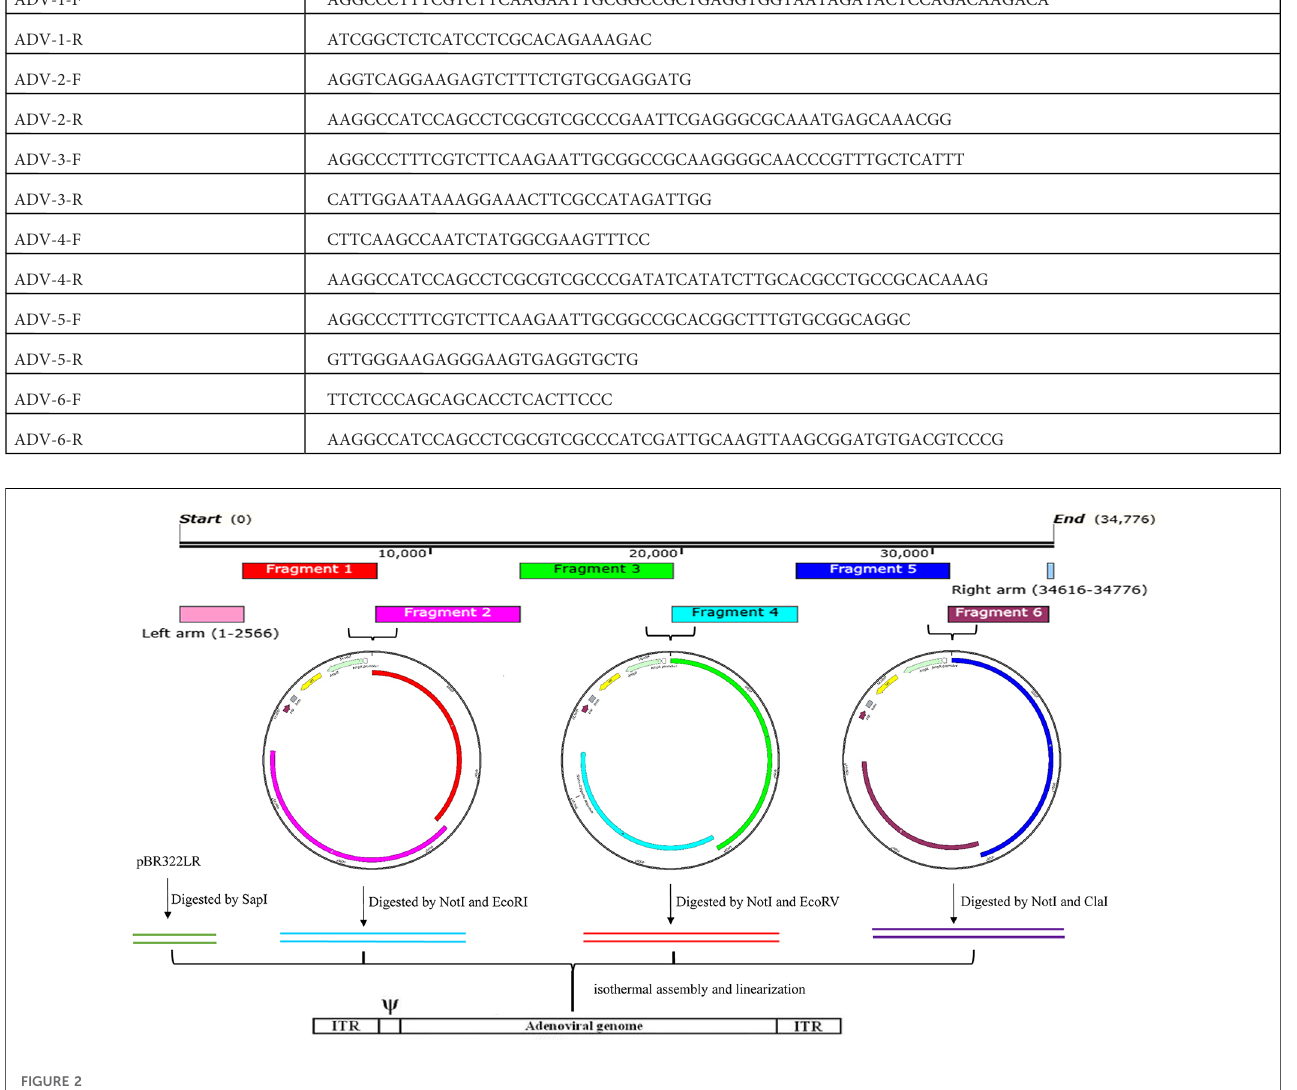
FIGURE 2 The overall strategy for the generation of recombinant adenoviruses. This includes, the layout of the AdV55 fragments, the cloning of two adjacent genomic DNA fragments into the pBR322 vector, the recovery of merged fragments by RE digestion, the isothermal reassembly of the whole genome and fi nally the linearization of the genome for the recovery of recombinant adenoviruses. The entire adenovirus genome, with the exception of the left and right arms contained in the pBR322LR, was divided and ampli fi ed into 6 fragments. Fragments 1 and 2, 3 and 4, or 5 and 6 were assembled as pairs by Gibson assembly with the Not/SbfI linearized pBR322 plasmid to generate three intermediate constructs (pBR322-1, 2; pBR322-3, 4; and pBR322-5, 6). These plasmids were then digested with two speci fi c restriction enzymes (Not/EcoRI, NotI/EcoRV, and NotI/ClaI, respectively) to release the three adenovirus fragments which were subsequently used to reassemble, together with the SapI linearized pBR322LR, the complete adenovirus genome within pBR322. Since the E3 region was replaced by the luciferase and GFP expression cassette, the fi nal plasmids containing the entire adenovirus genome were